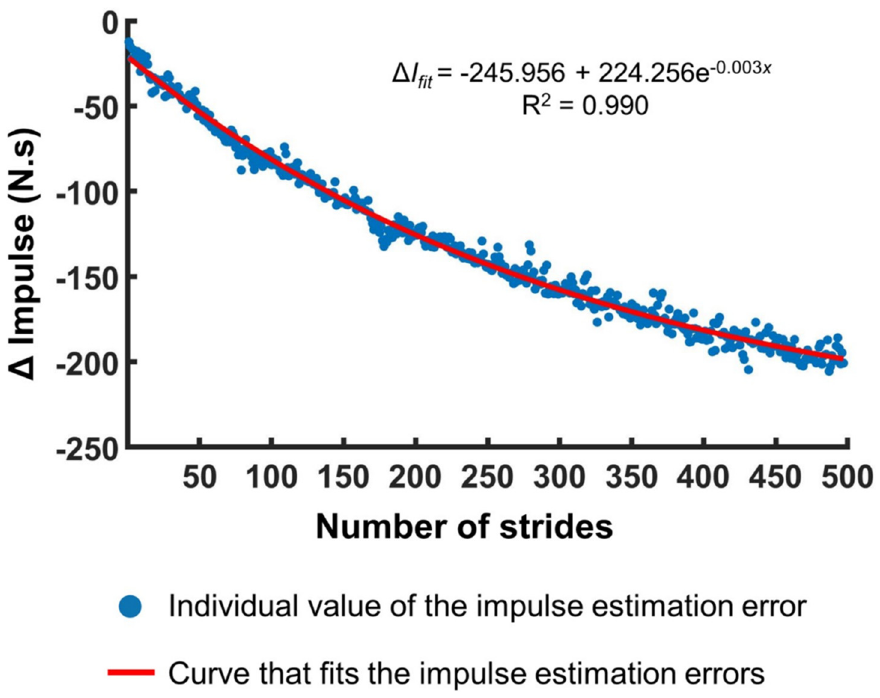
Figure 5. A representative figure illustrating the curve-fitting model that encapsulates the VGRF estimation error over strides. The blue circles are the individual impulse estimation error values for each stride, and the red line is the curve used to encapsulate the temporal changes in the impulse estimation errors. Table 3. The results of two-way repeated measures ANOVA for R 2 .